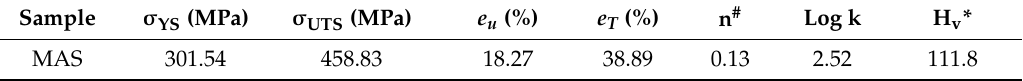
Table 3. Mechanical properties of MAS in as-received